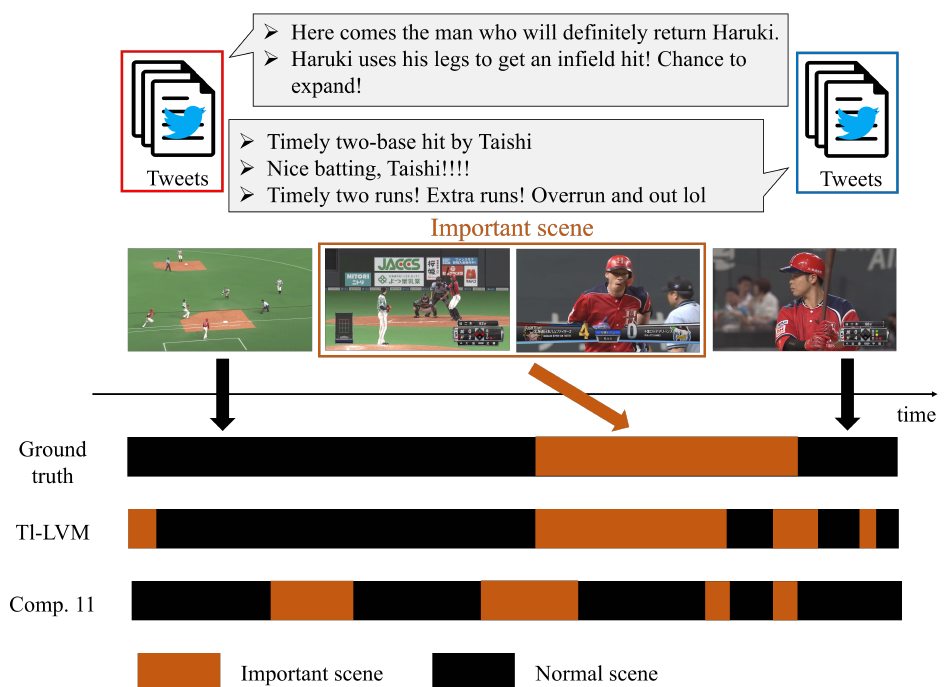
Figure 3. Example of an important scene correctly predicted by Tl-LVM and tweets containing content from this scene. Furthermore, the horizontal axis represents time. Ground truth corresponding to this scene and labels (predicted by Tl-LVM and Comp. 11) are shown with respect to time. There is a time lag between when this important scene occurs and when these tweets are posted.